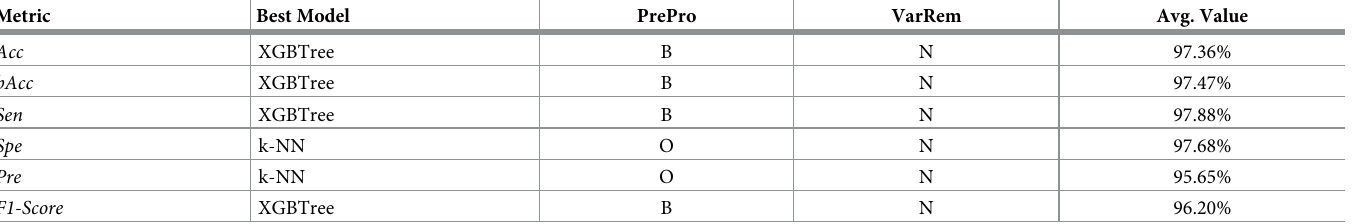
Table 5. XGBTree achieved best performance in most of the evaluation metrics (PrePro—Pre-processing type (B—Balanced (ENUS), O—Original data); VarRem— Variable removal (Y—Yes, N—No)).